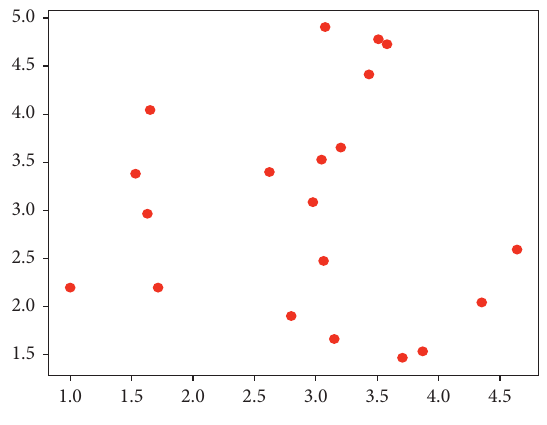
Figure 5: Random points graph of zone (1, 5).